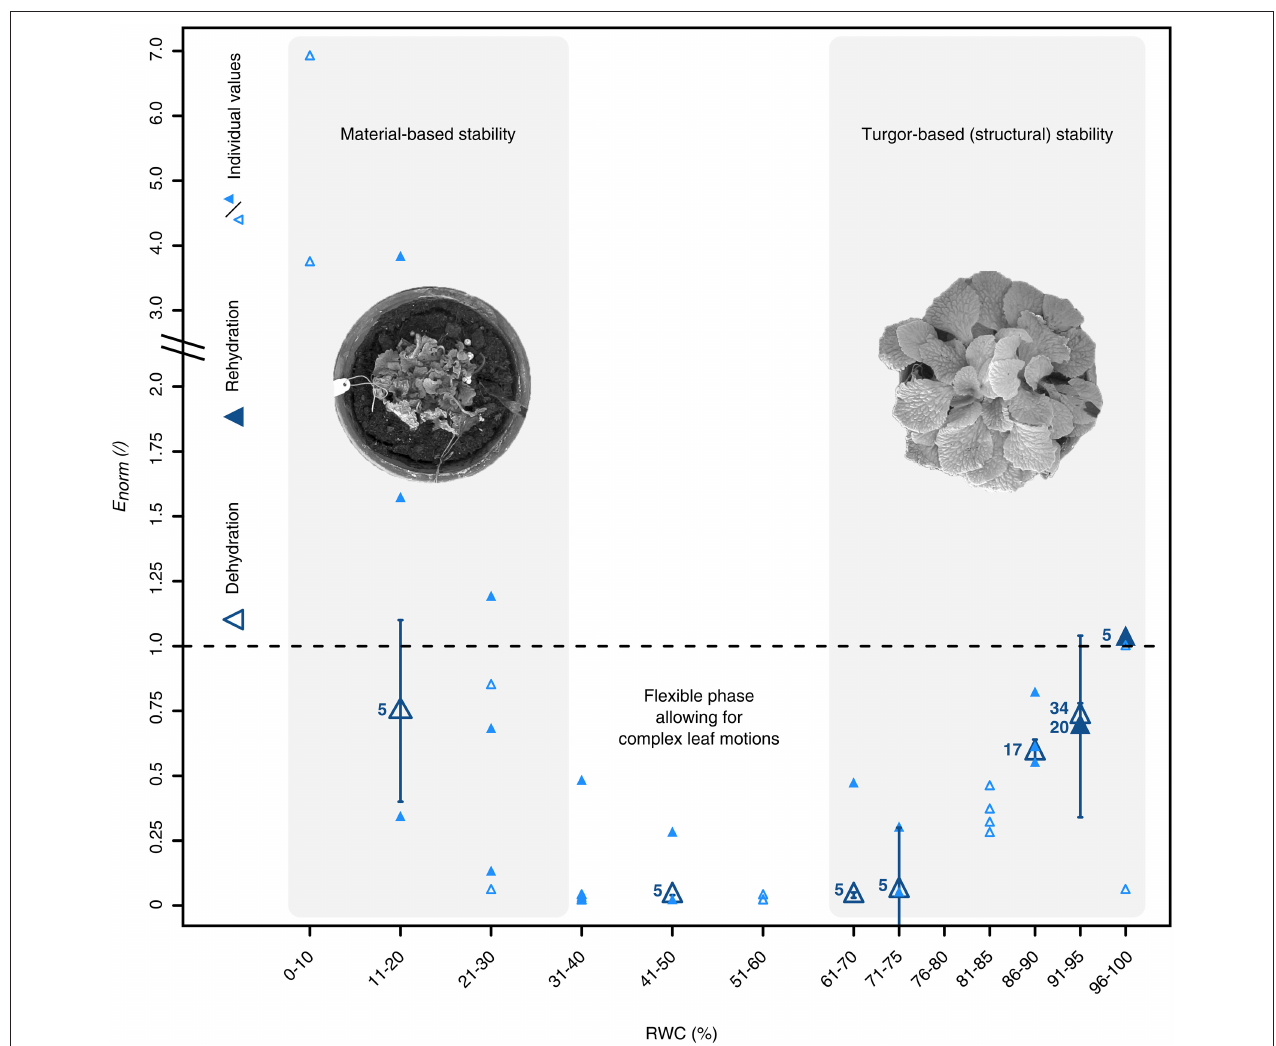
FIGURE 5 | Water status dependent alterations of the petiolar biomechanics of R. myconi . Dehydration (open triangles) induces a triphasic mechanical behavior, which is characterized by a turgor-based structural stability at high and a material-based stability at low water contents, and is fully reversible upon rehydration (closed triangles). The structural bending elastic moduli ( E ) have been normalized to the median bending modulus at RWCs > 90%. The normalized bending elastic moduli ( E norm ) of each RWC interval are either given as median ± standard error of the median ( N ≥ 5, large dark-blue symbols), or as individual values ( N < 5, small light-blue